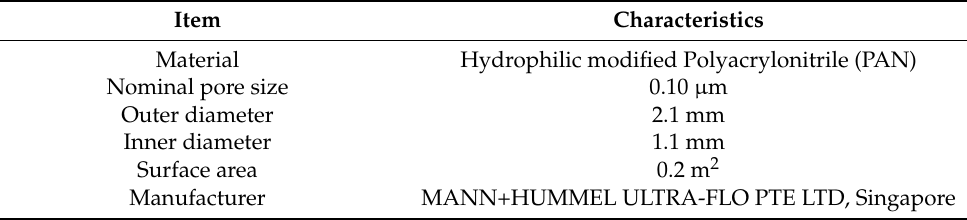
Table 1. Characteristics of the hollow fibre